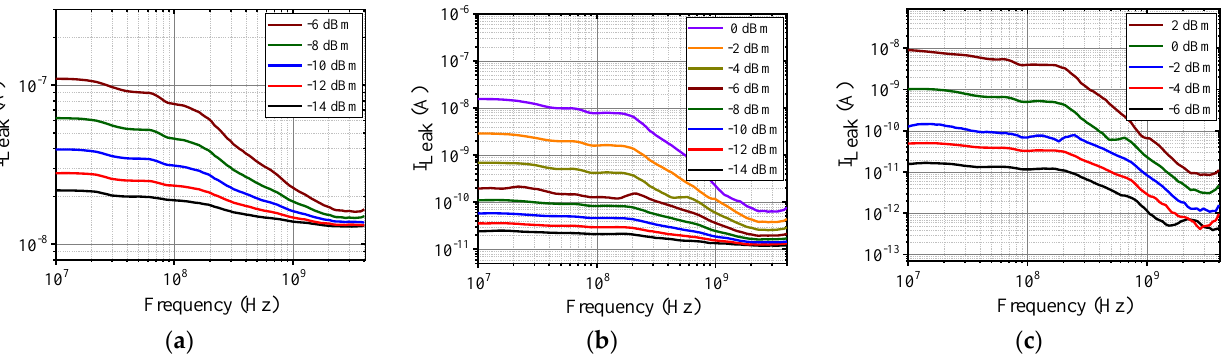
Figure 9. The measured leakage current due to a PMOS for a 1× inverter fabricated in the ( a ) 65nm, ( b ) 130 nm, and ( c ) 180 nm standard CMOS technology node.